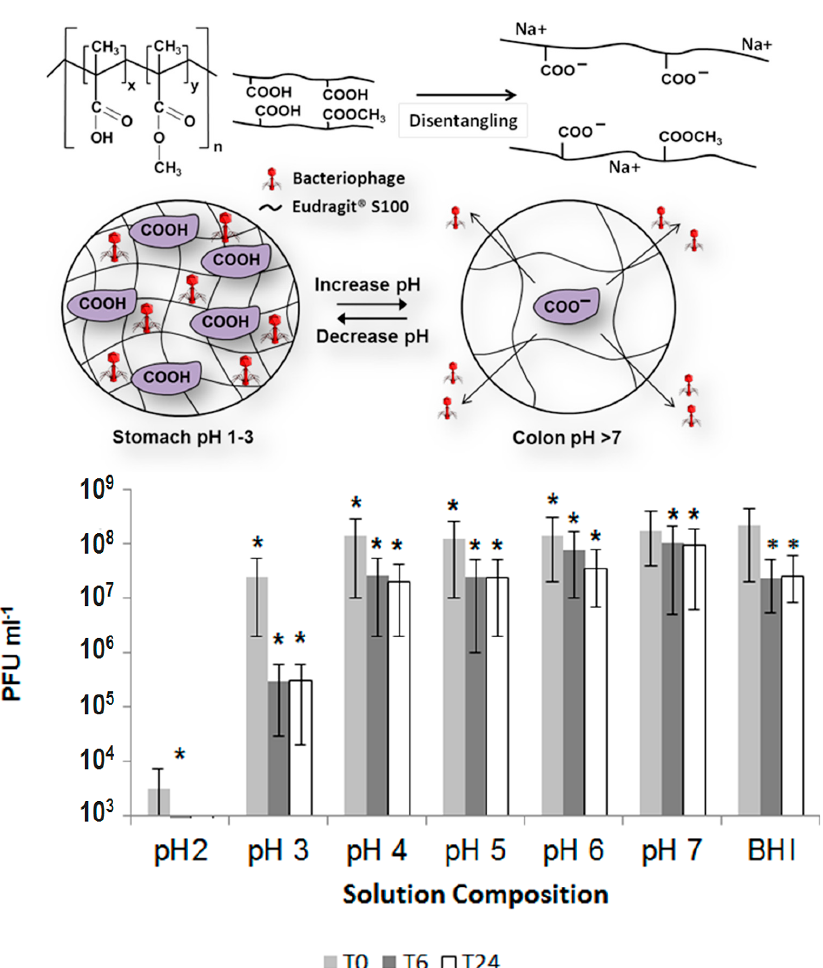
Figure 3. ( Top ) Concept of encapsulation of bacteriophages within an ionic hydrogel. At low pH, the carboxylate groups remain protonated, and the hydrogel does not swell with the acidic fluids of the stomach. Once the particles reach the small intestine, the change in pH causes the carboxyl groups to become deprotonated (hence changed and more polar), which causes the hydrogel to swell and release the encapsulated bacteriophages. ( Bottom ) Number of plaque forming units from a system with encapsulated bacteriophages after 0 h (T0), 6 h (T6), and 24 h (T24) of residence within the hydrogel particles at the given pH values. (* indicates significantly different phage titres using a 2 sample t -test at each condition compared with phage at T0 for each composition ( p < 0.05).). (Adapted and reproduced with permission from